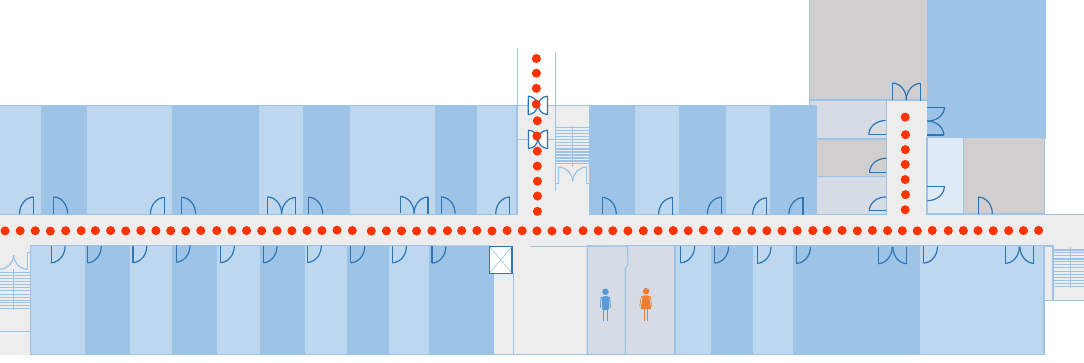
Figure 10. The magnetic fingerprint database making